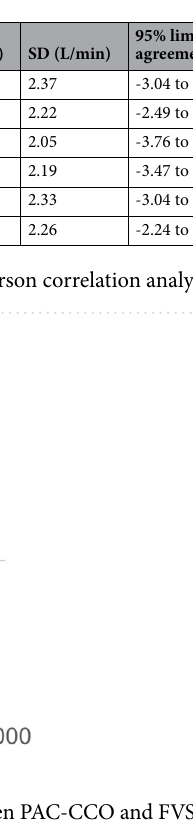
Figure 4. Plot of SVR against the differences between PAC-CCO and FVS-CCO. Seven SVRs were missing ( n = 1510). Very large difference was shown in the low SVR